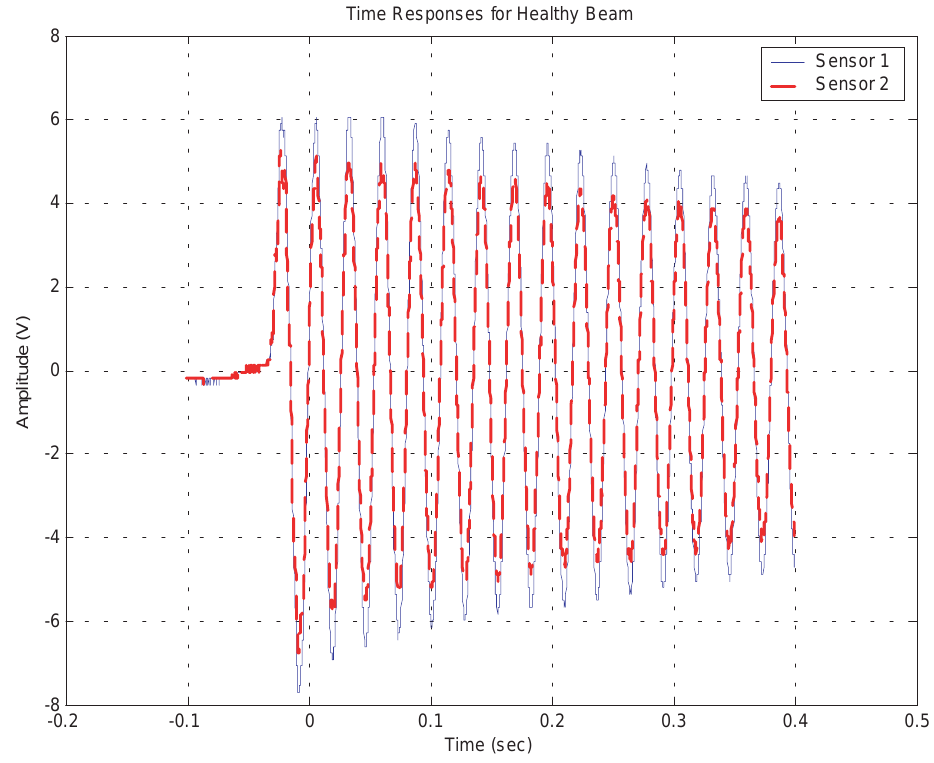
Fig. 5. Transient time responses for sensors S1 and S2 on the healthy beam. (a) Wavelet Transform from sensor 1 for the healthy beam. (b) Wavelet Transform from sensor 2 for the healthy